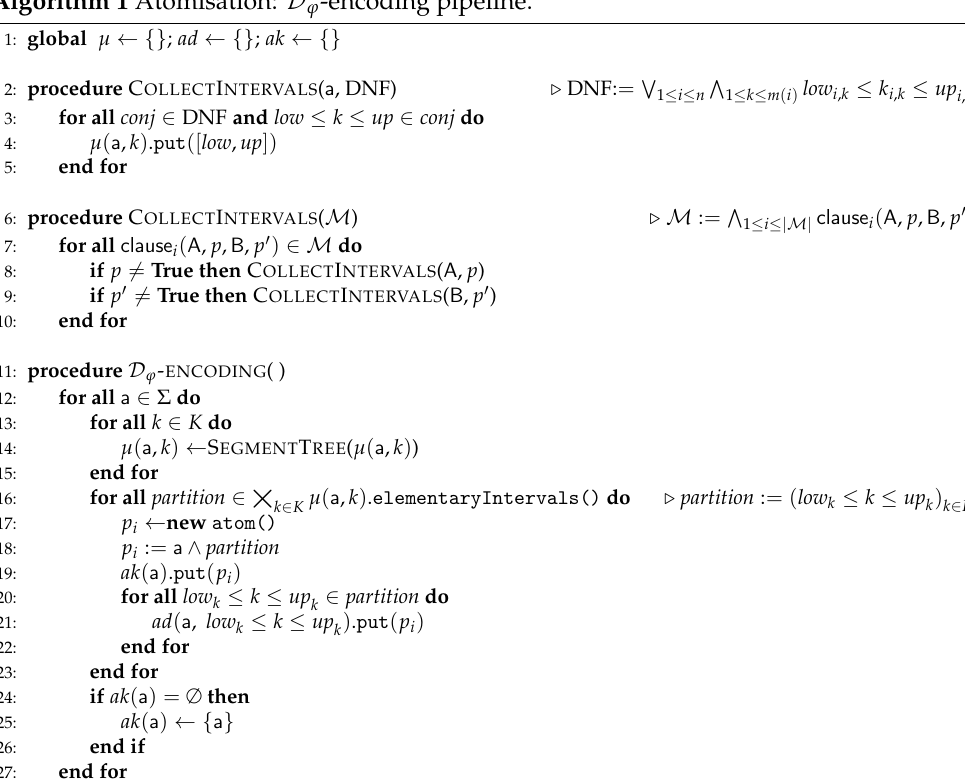
Algorithm 1 Atomisation: D ϕ -encoding